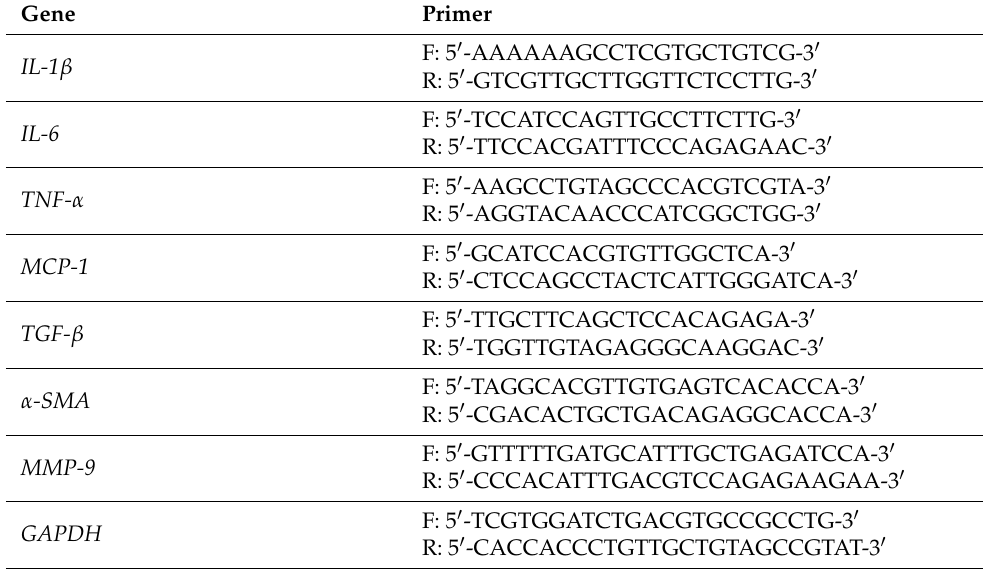
Table 1. Primers used to amplify target